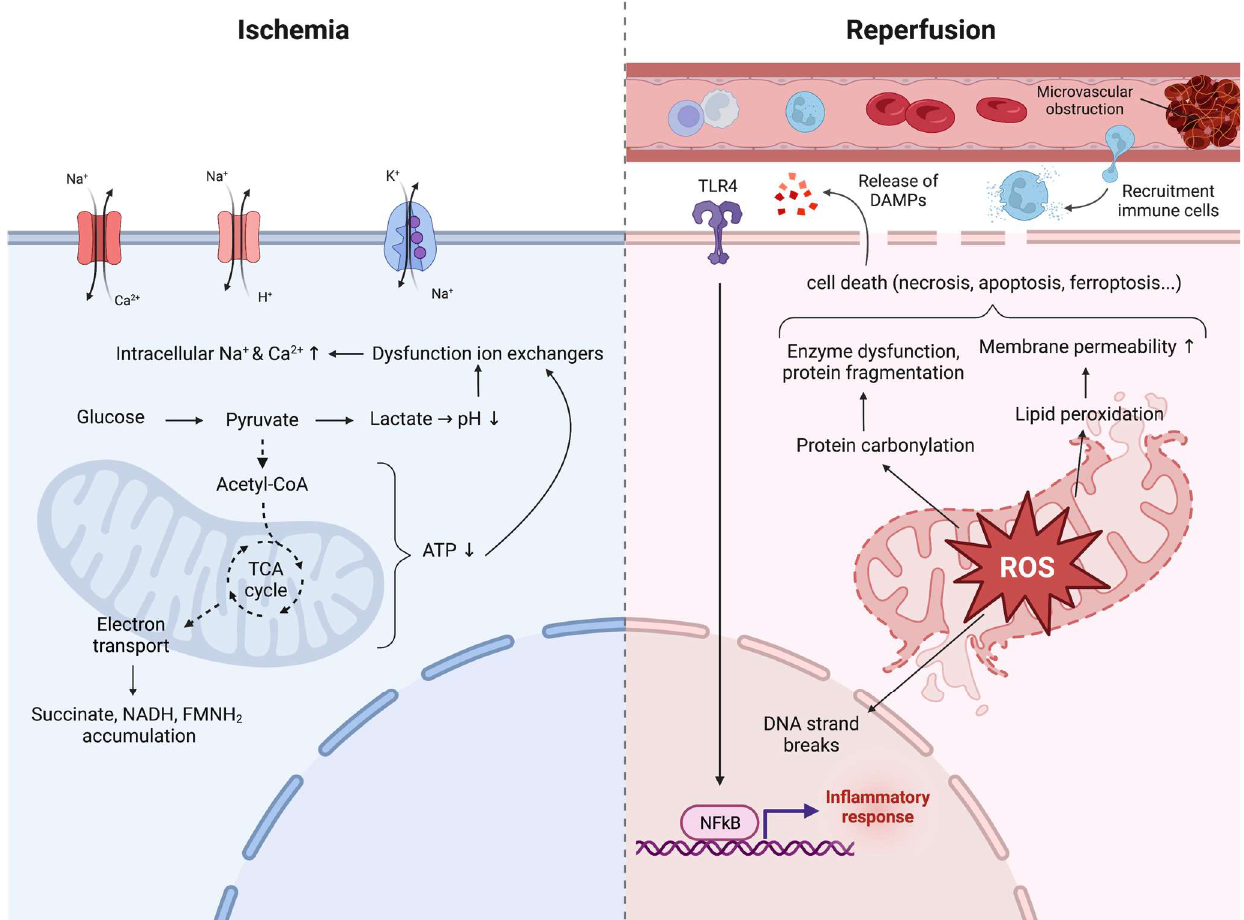
Figure 1. Simplified scheme of renal ischemia–reperfusion injury pathophysiology. DAMP, damage-associated molecular patterns; ROS, reactive oxygen species; TLR4, Toll-like receptor 4.